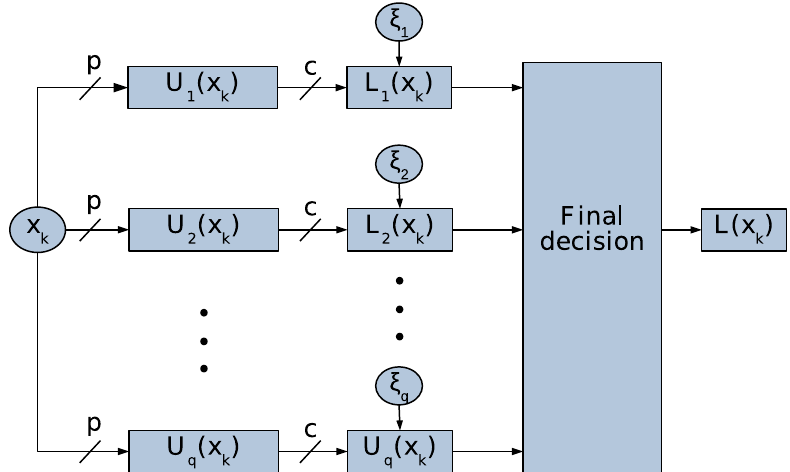
Figure 2. Multi-competitive-layer neural network. x k is an object vector, p is the dimension of the data space, i.e., the number of features per object vector, c is the number of clusters that form the training data set X , U q is the vector of membership degrees of x k to all classes of layer q , L q is the local decision (Equation (12)), and L is the global or the final decision (Equation